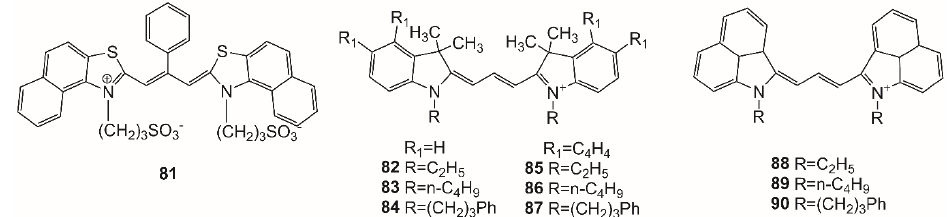
Figure 18. Structures of cyanines 81–90 .